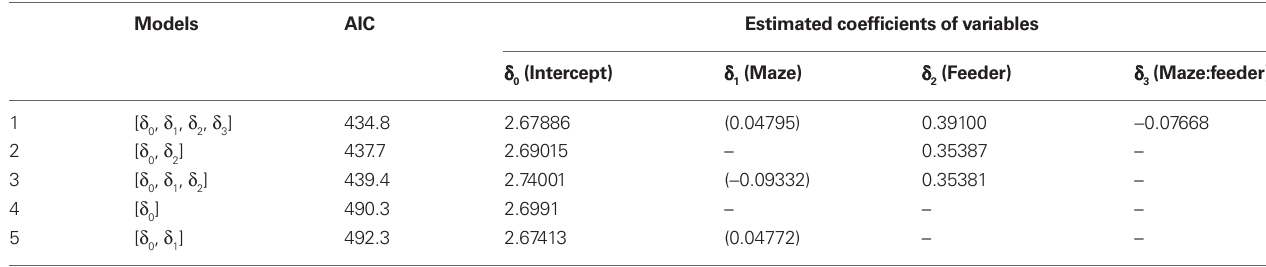
Table A5 | The maze–feeder-and-interaction model yielded the smallest AiC.